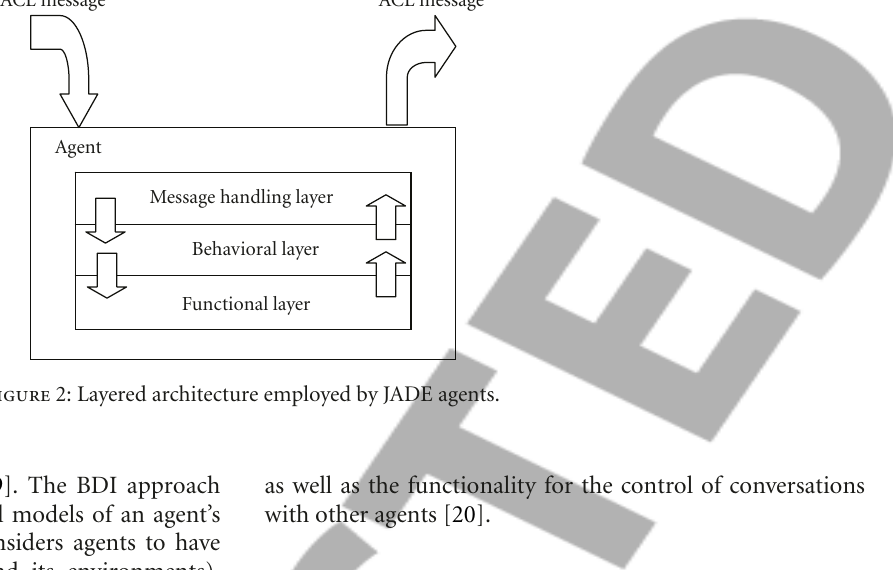
Figure 2: Layered architecture employed by JADE